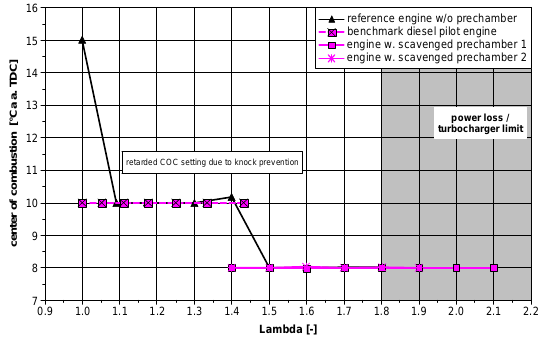
Fig. 10. Peak cylinder pressures for the operating point 2 (2000 rpm/ 220 Nm/bmep 14.0 bar)